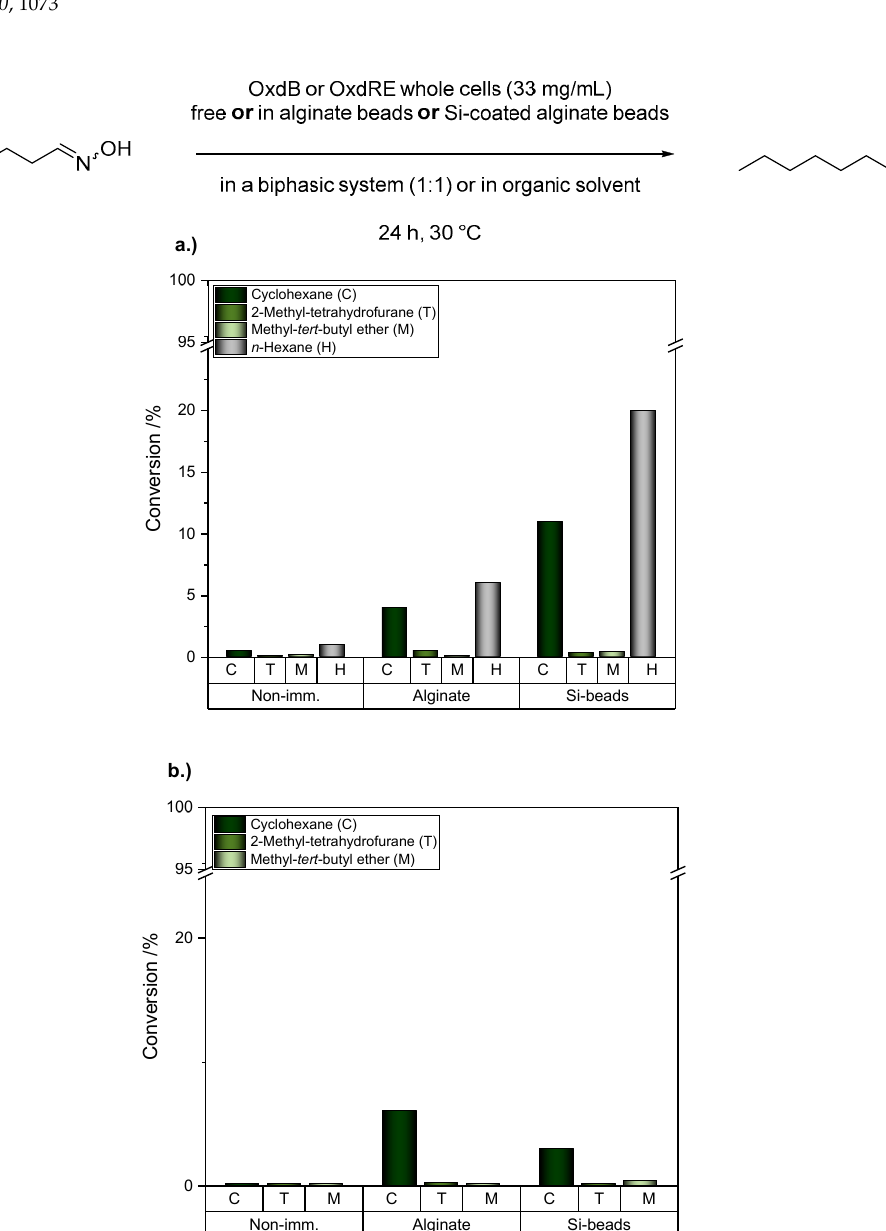
Figure 6. Dehydration of n-octanaloxime using immobilized whole cells in calcium alginate beads (alginate) or Si-coated calcium alginate beads (Si-beads) in pure organic medium compared to free whole cells in a biphasic reaction medium of OxdB ( a ) and OxdRE ( b ). In the y-axis an interruption from 25 to 95% is inserted.